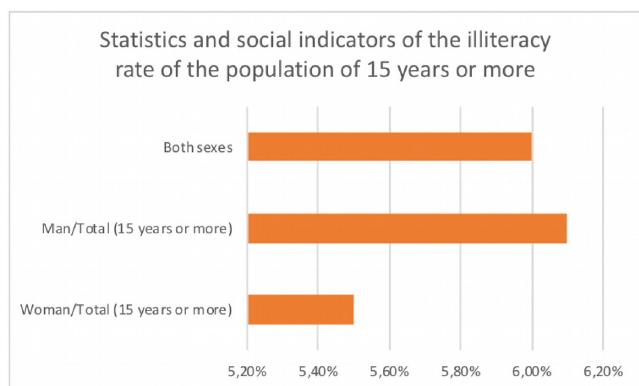
Figure 3. Statistics and social indicators of the illiteracy rate of the population of 15 years or more (Economic Commission for Latin America and the Caribbean, CEPAL,